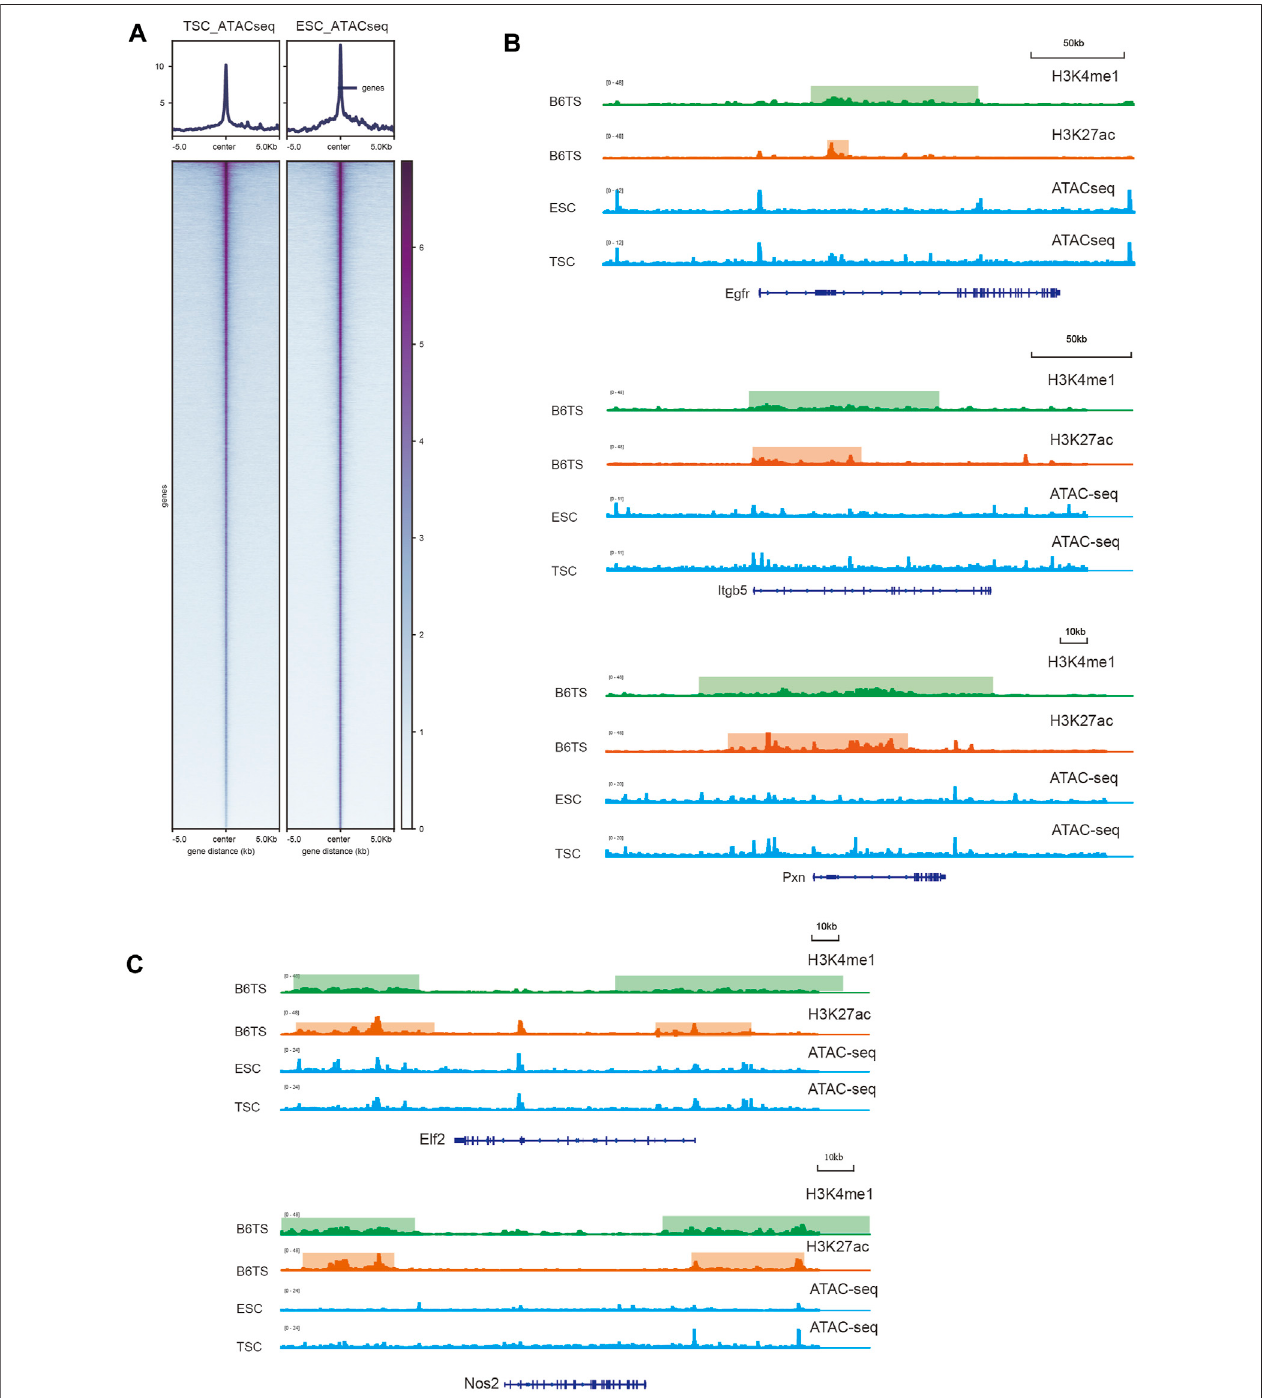
FIGURE6| Evaluationofthechromatinaccessibilityofkeycell identity genes. (A) Heatmaps showing thegeneral signal levels identi fi ed byATAC-seq inESCs and TSCs. (B) H3K27ac and H3K4me1 signals of TSCs (B6TS) and ATAC-seq signals of ESCs and TSCs at Egfr, Itgb5, Pxn. (C) H3K27ac and H3K4me1 signals of TSCs (B6TS) and ATAC-seq signals of ESCs and TSCs at Elf2 and Nos2.